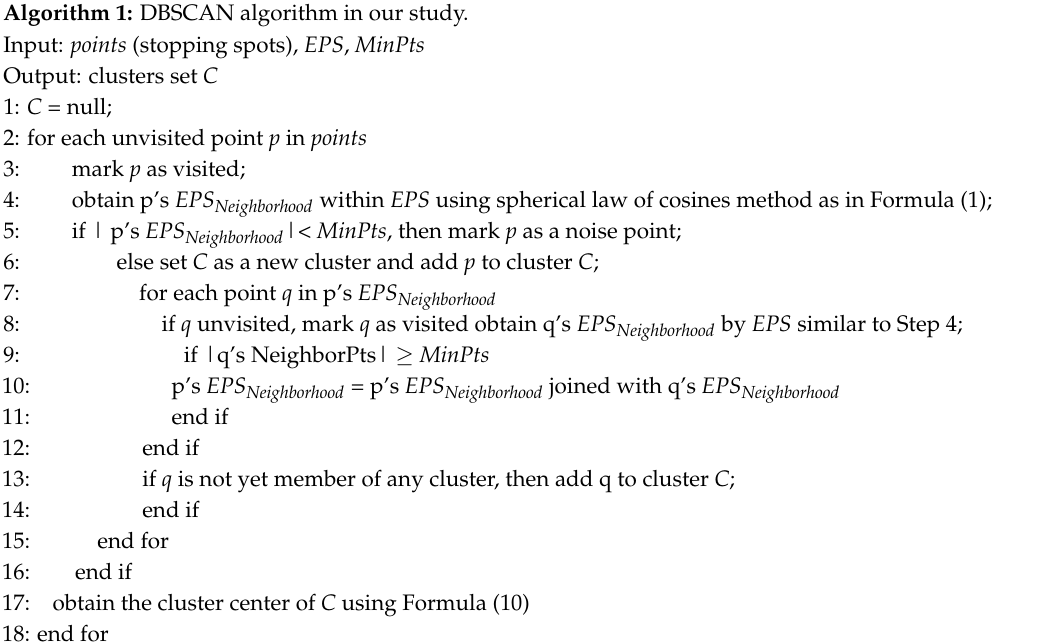
Algorithm 1: DBSCAN algorithm in our